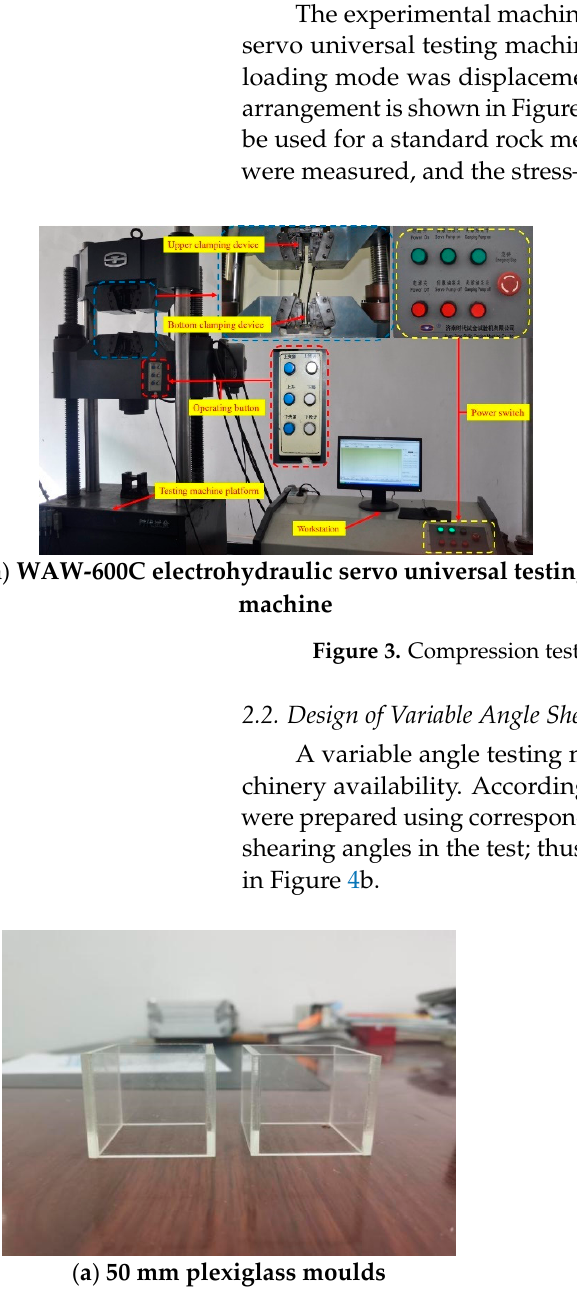
Figure 4. Shear moulds and TSL samples.